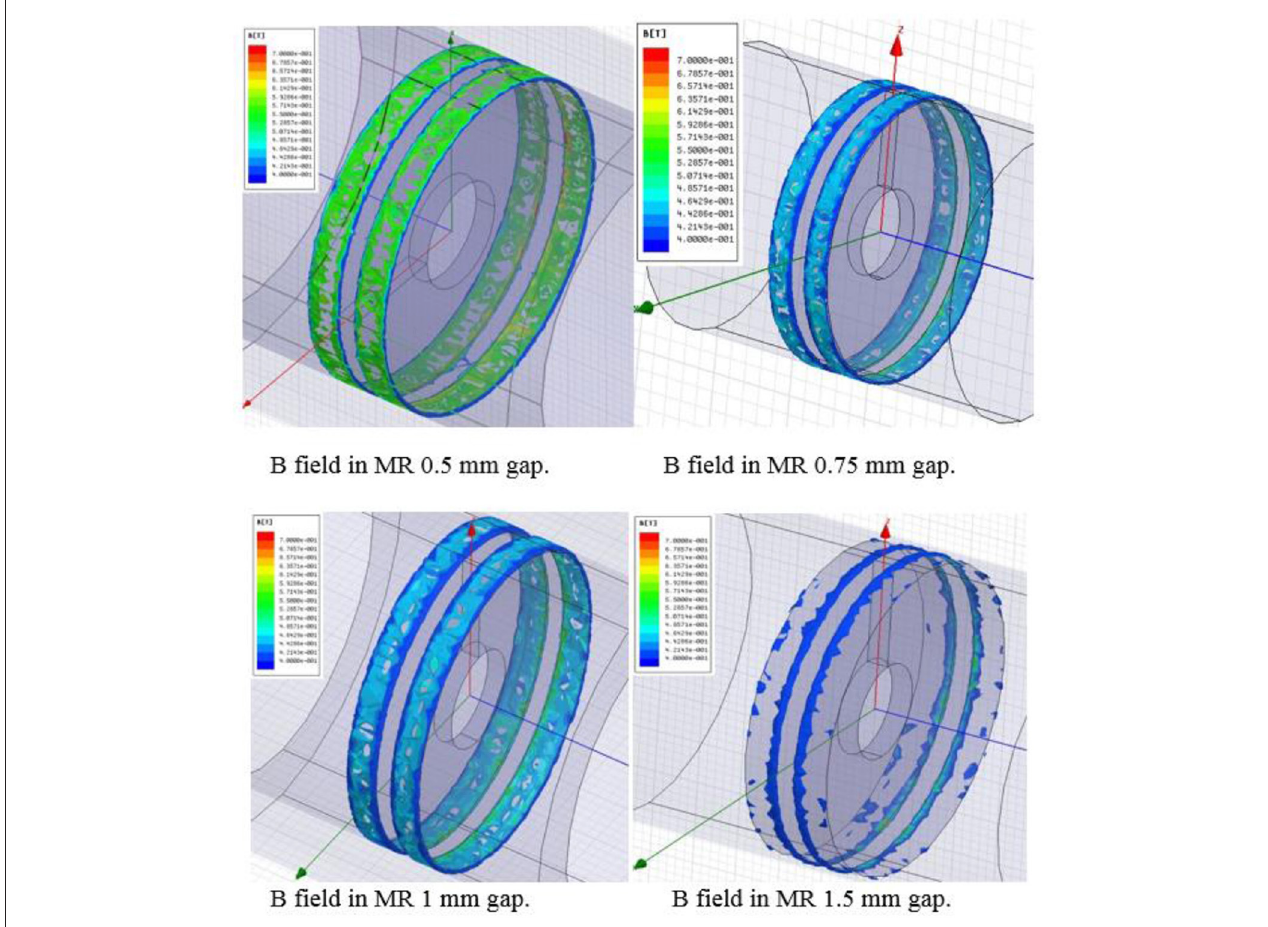
FIGURE 5 | The magnetic field in the MRF is shown to decrease as the gap is increased.